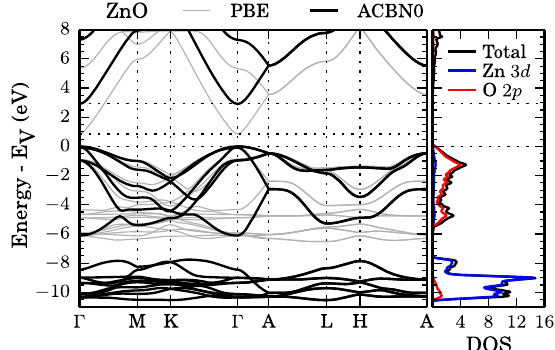
FIG. 3. Band structure (spin up) of nickel oxide. All energies FIG. 4. Comparison between the PBE (gray) and ACBN0 . The effective are relative to the valence-band maximum E V 7 . 63 eV for nickel and U 3 . 0 eV for oxy- (black) band structures for ZnO. The converged effective Cou- values of U 3 2 p ¼ d ¼ 12 . 8 eV and O U 5 . 29 eV. lomb interactions are Zn U 3 gen are used in the ACBN0 calculation. 2 p ¼ d ¼ The horizontal grid lines show the DFT (0.85 eV) and ACBN0 (2.91 eV) band gaps. The panel on the right shows the projected DOS for the ACBN0